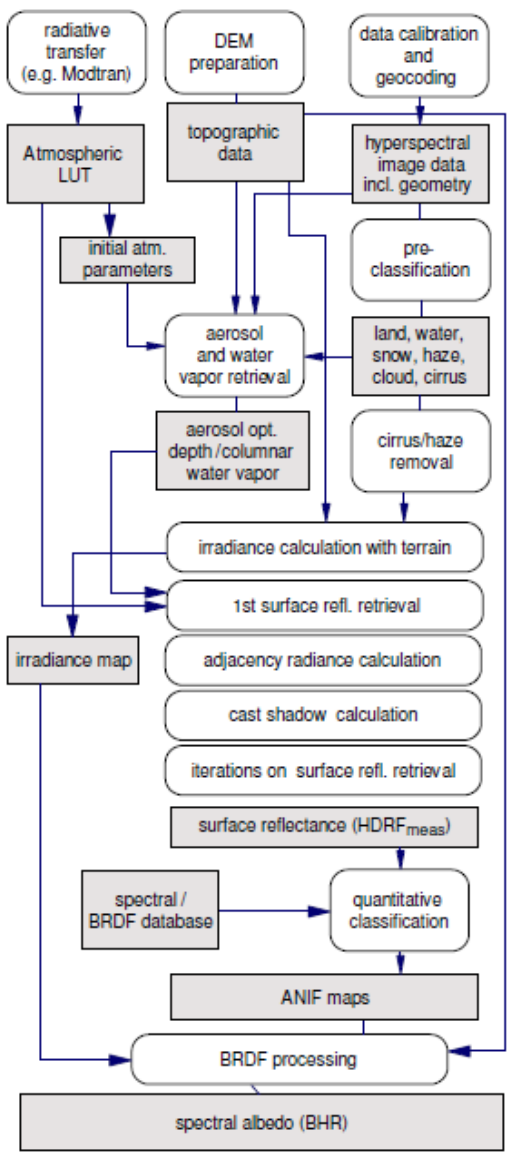
Figure 10. As in [74], courtesy of Daniel Schläpfer, ReSe Applications Schläpfer. A complete (“augmented”) hybrid (combined deductive and inductive) inference workflow for multi-spectral (MS) image correction from atmospheric, adjacency and topographic effects. It combines a standard Atmospheric/Topographic Correction for Satellite Imagery (ATCOR) commercial software workflow [71,72], with a bidirectional reflectance distribution function (BRDF) effect correction, which requires as input an image time-series of the same surface area acquired with different combinations of the sun and sensor positions. Processing blocks are represented as circles and output products as rectangles. This hybrid workflow alternates deductive/prior knowledge-based and inductive/learning-from-data inference units, starting from initial conditions provided by a first-stage prior knowledge-based decision tree for static (non-adaptive to data) color naming, such as the Spectral Classification of surface reflectance signatures (SPECL) decision tree [73] implemented within the ATCOR commercial software toolbox. Categorical variables generated as output by the two processing blocks identified as “pre-classification” and “classification” are employed as input by the subsequent processing blocks to stratify (mask) unconditional numeric variable distributions, in line with the statistic stratification principle [152]. Through statistic stratification, inherently ill-posed inductive learning-from-data algorithms are provided with a priori knowledge required in addition to data to become better posed for numerical solution, in agreement with the machine learning-from-data literature